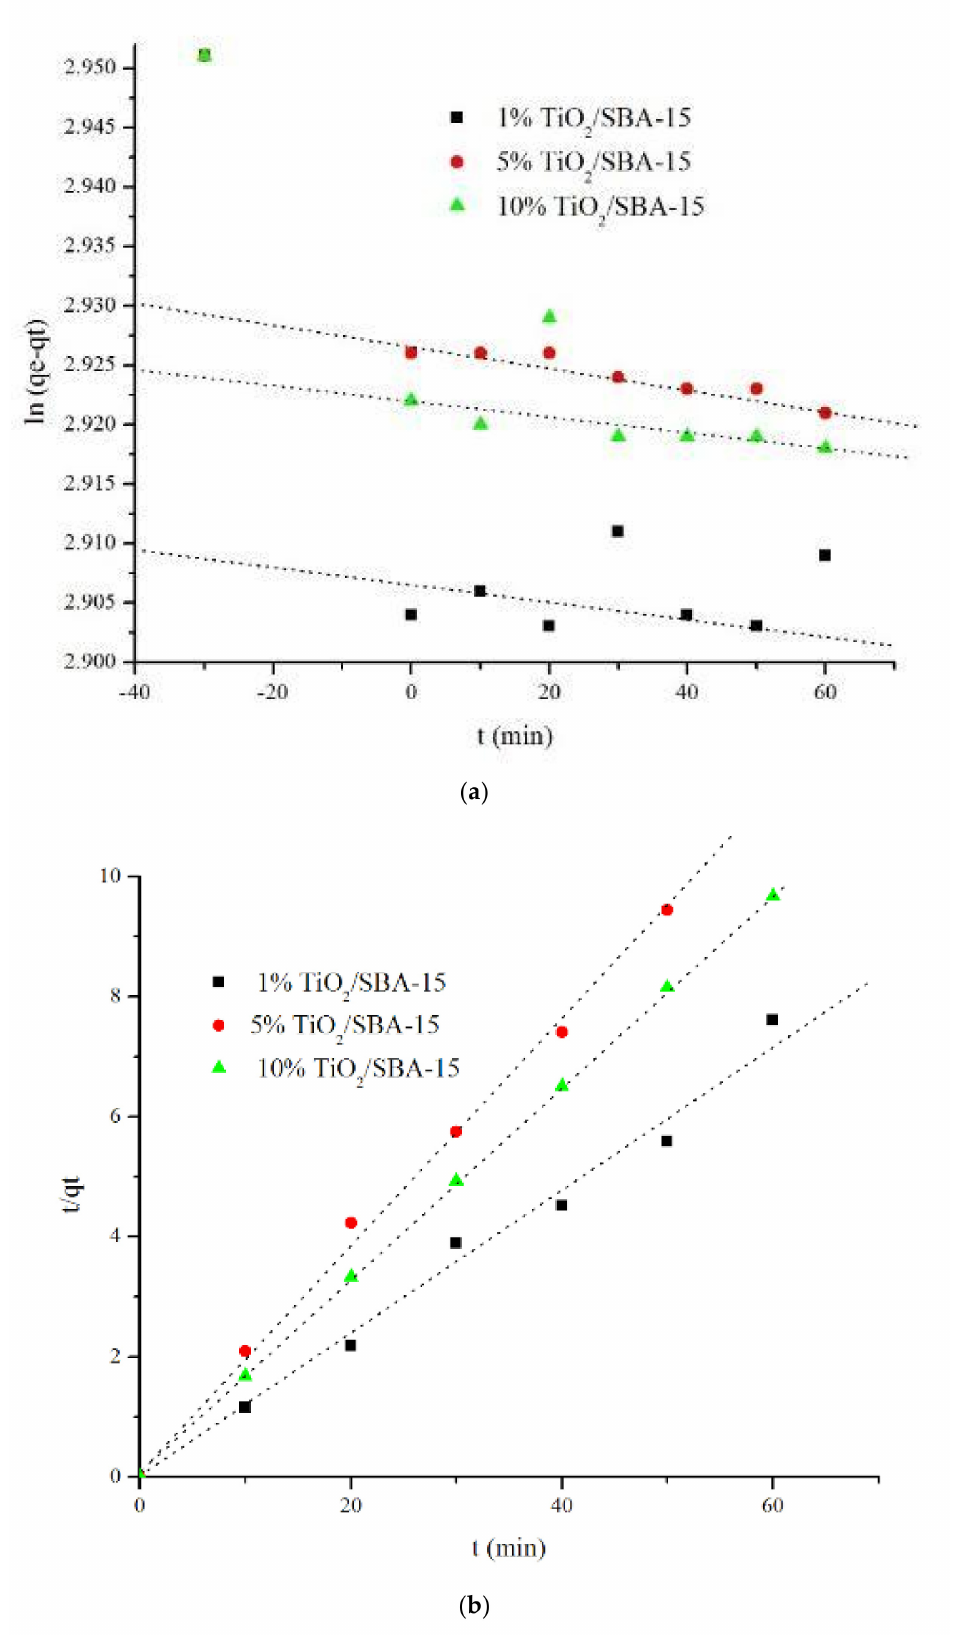
Figure 10. Kinetic models of dark adsorption-photodegradation of methylene blue using TiO 2 /SBA-15 by pseudo ( a ) first and ( b )